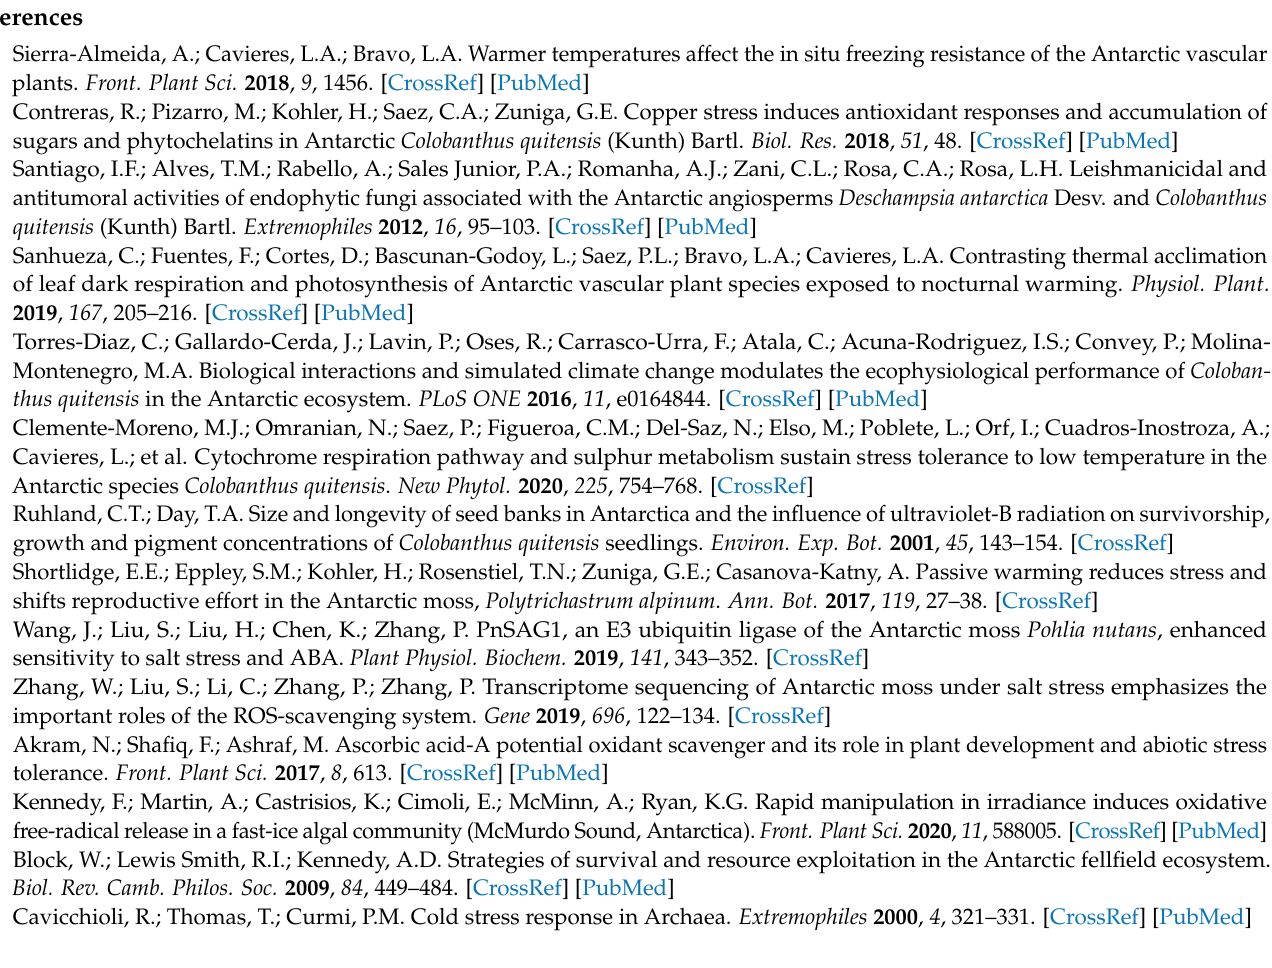
Table S5: GO-based classification of downregulated genes in DaMDHAR -expressing yeast cells, Table S6: KEGG-based classification of downregulated genes in DaMDHAR -expressing yeast